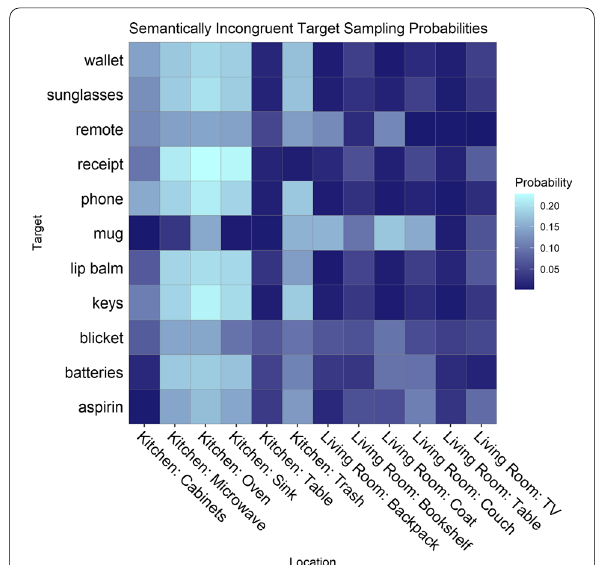
Fig. 4 Heatmap displaying the calculated probability of each target (11 targets, y -axis) occurring in each location (12 locations, x -axis) in the kitchen and living room scenes. The probabilities are incongruent with the semantics of the scene. Note that the scale here differs from the congruent probabilities show in Fig. 3 (the maximum probability value is